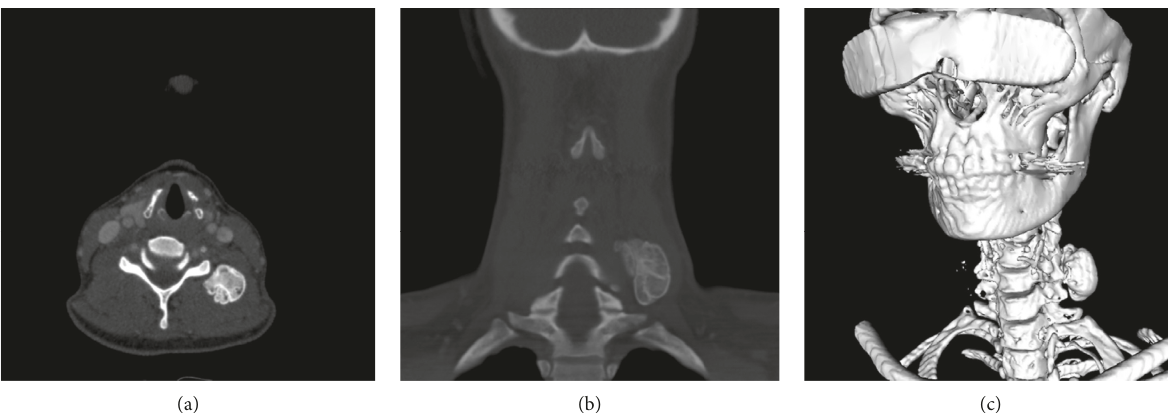
Figure 1: Preoperative computertomography scan: axial (a), coronary (b), and 3D-reconstruction (c). The CTscan shows a calcificated mass without contact to the skeleton.